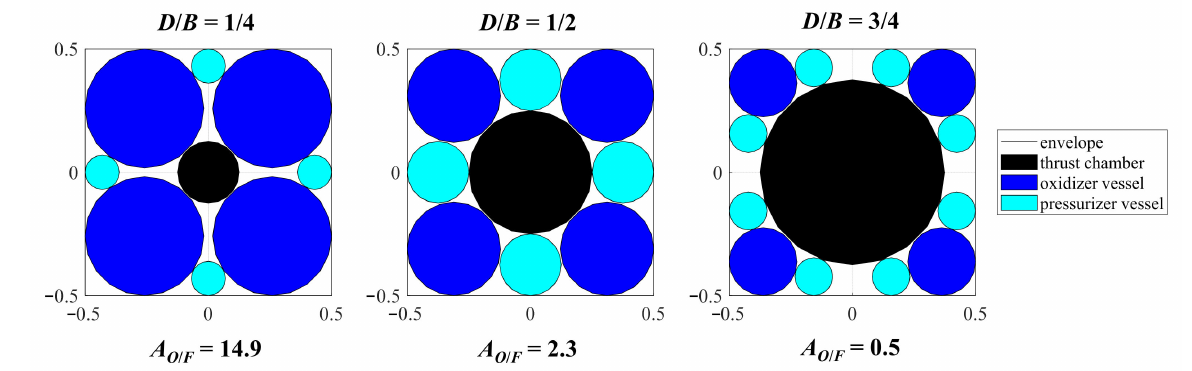
Figure 5. Increasing thrust chamber size decreases oxidizer capacity